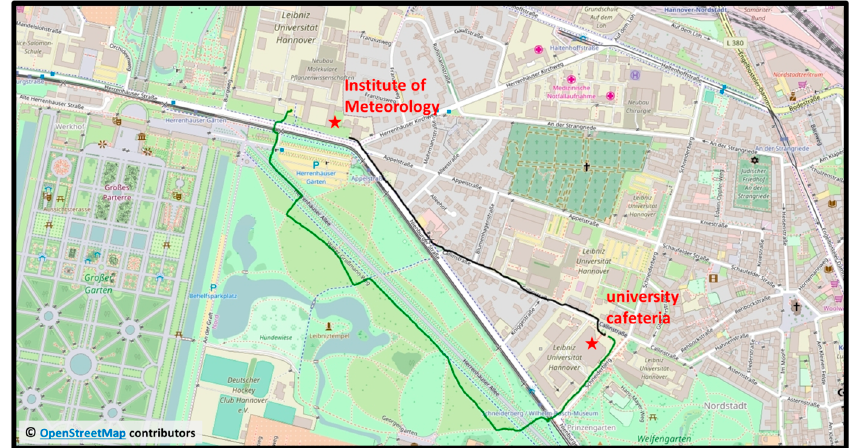
Figure 4. Visualized GPS-data of the two different routes used for the exposure calculation of a moving human in an urban environment. The routes start at the Institute of Meteorology and Climatology and end at the university cafeteria and follow paths through built-up areas (black line) and a recreational park (green line). Map data © OpenStreetMap contributors, CC BY-SA